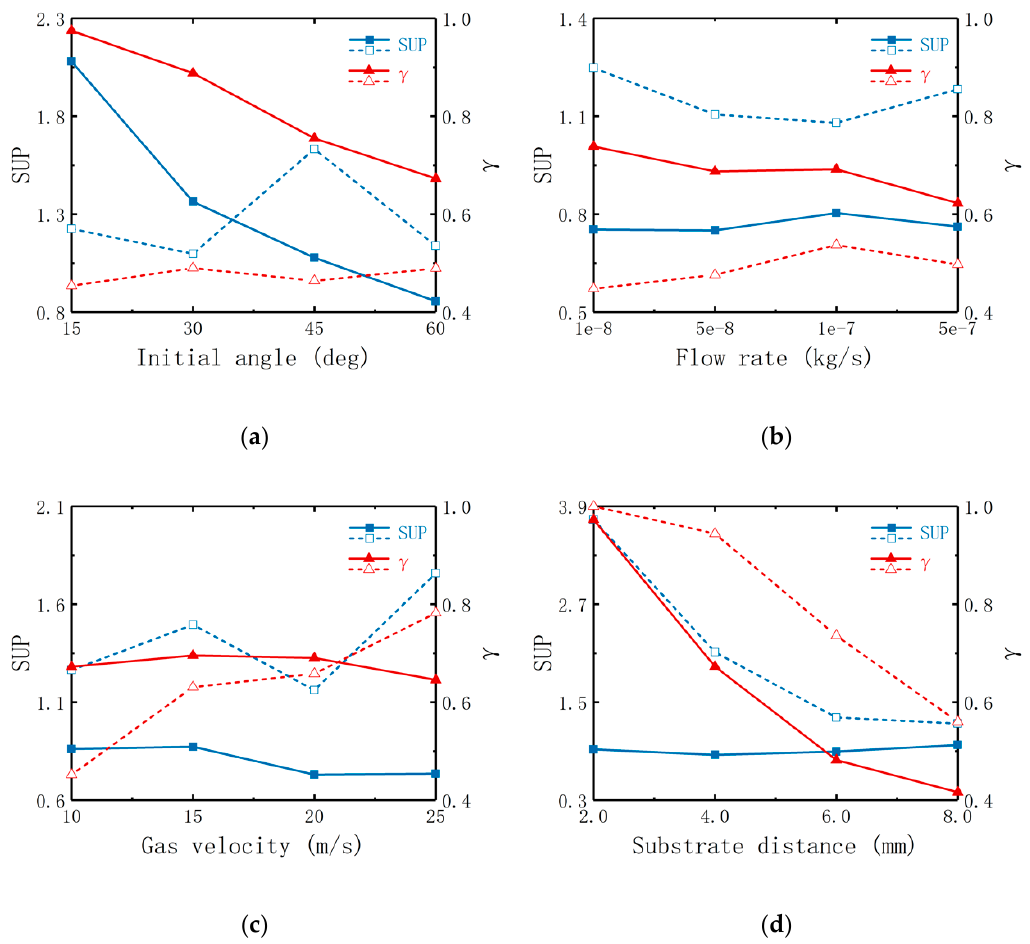
Figure 3. The uniformity and the utilization ratio of the two nozzles under the influence of ( a ) initial angle, ( b ) flow rate, ( c ) gas velocity and ( d ) substrate distance. The solid line represents the variable of the internal mixing nozzle, while the dotted line represents the variable of the external mixing nozzle.